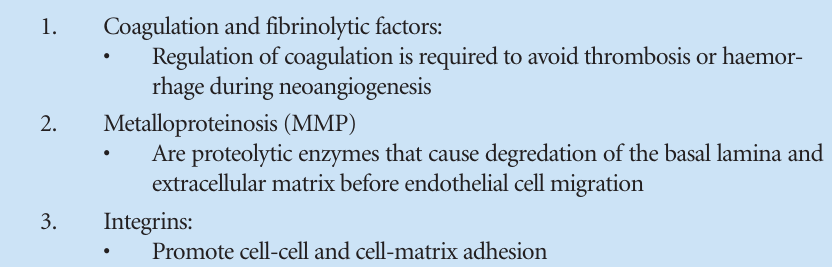
Table II. Extracellular matrix factors 2